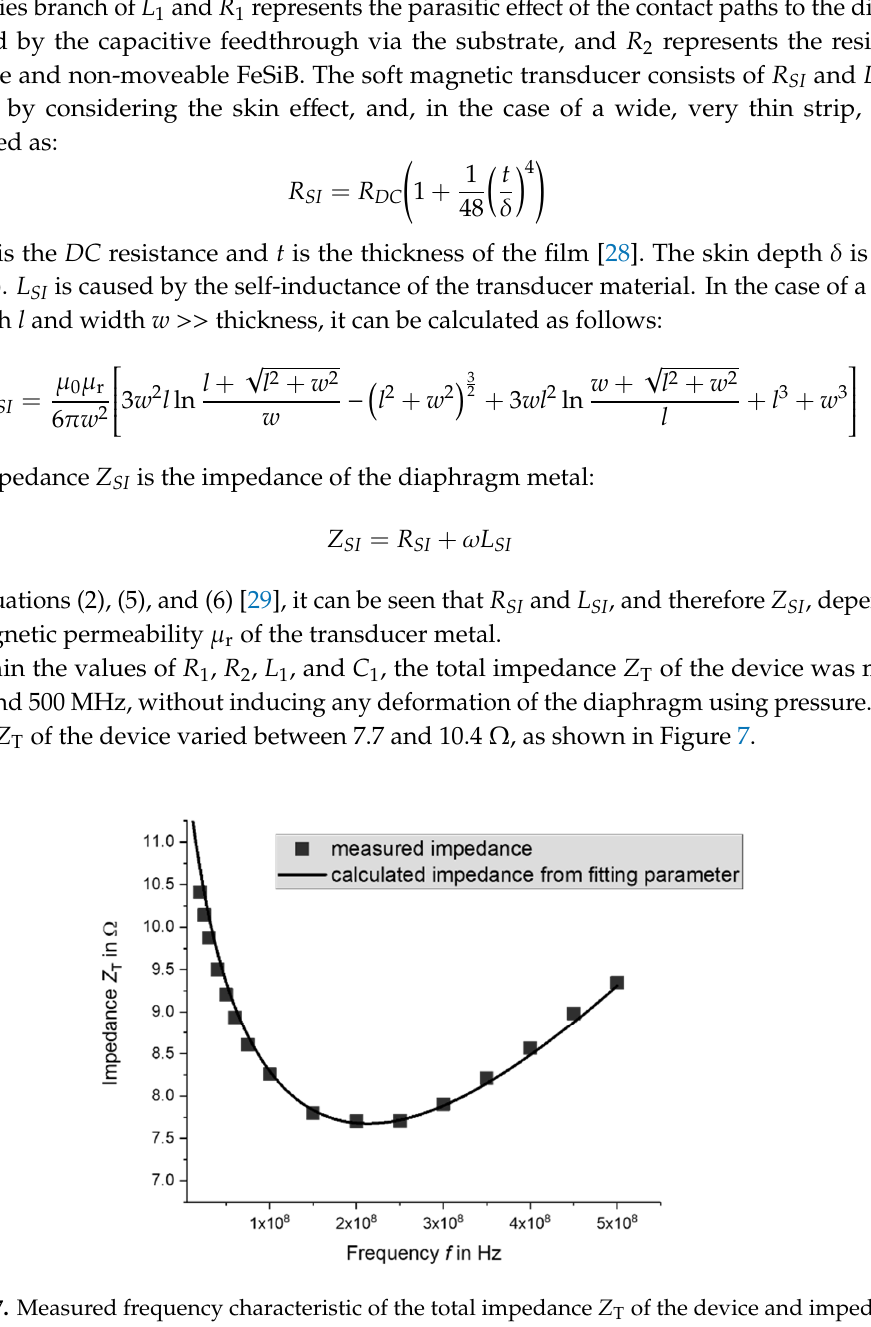
Table 2. Values of the element of the lumped equivalent circuit (Figure 6) obtained by fitting.